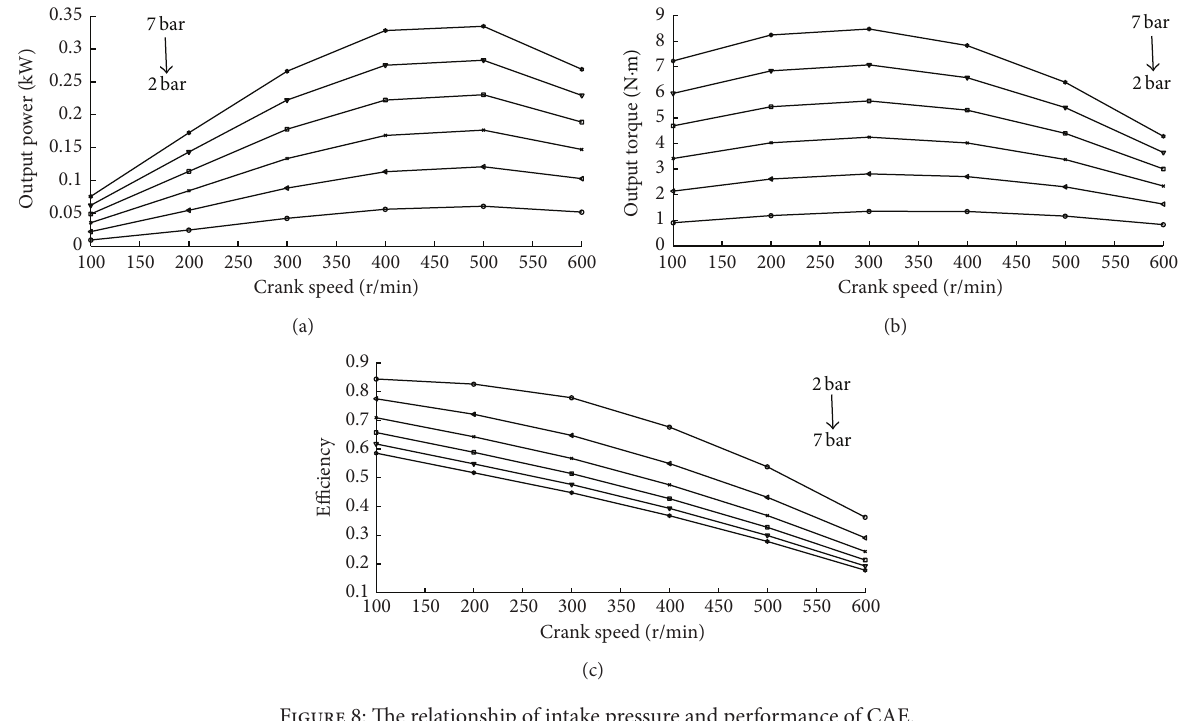
Figure 8: The relationship of intake pressure and performance of CAE.